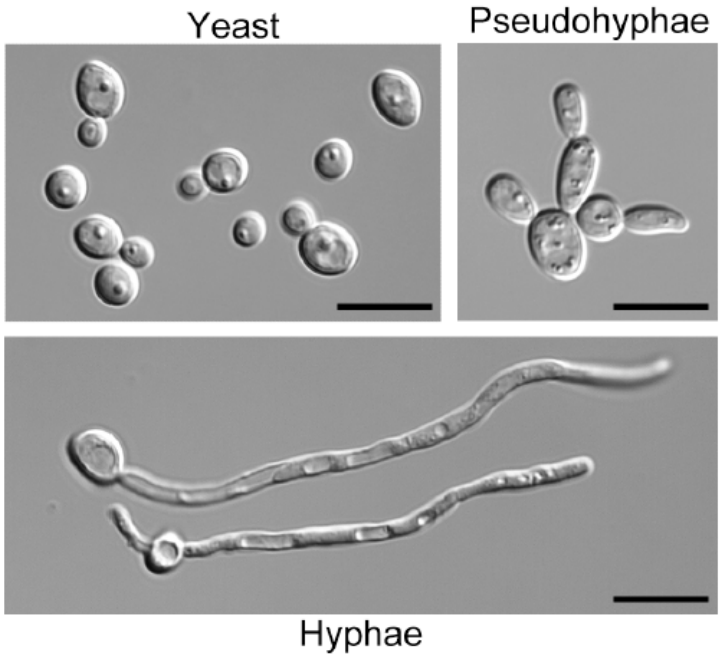
Figure 2. GlcNAc induction of filamentous hyphal morphology. Budding cells were grown in synthetic glucose medium to observe the yeast form, and then switched to medium containing 50 mM